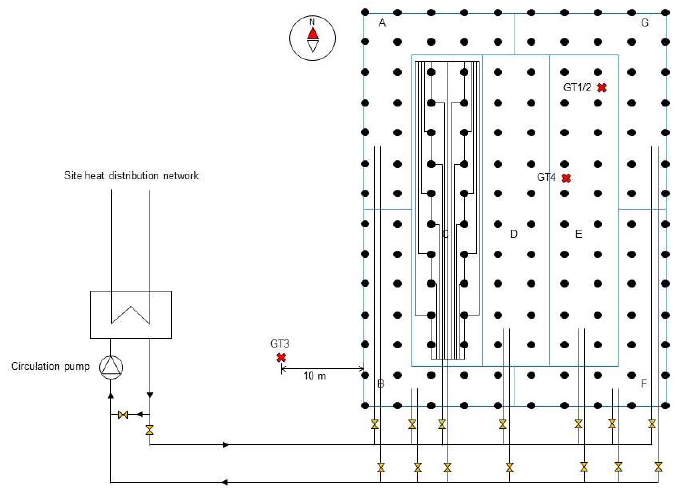
Figure 2. Layout of the borehole thermal energy storage (BTES) at Xylem, Emmaboda. The BTES consists of 140 boreholes, divided into seven sections, A–G, of 20 boreholes each. GT1–4 are temperature sensors inserted into the ground for storage operation and monitoring.